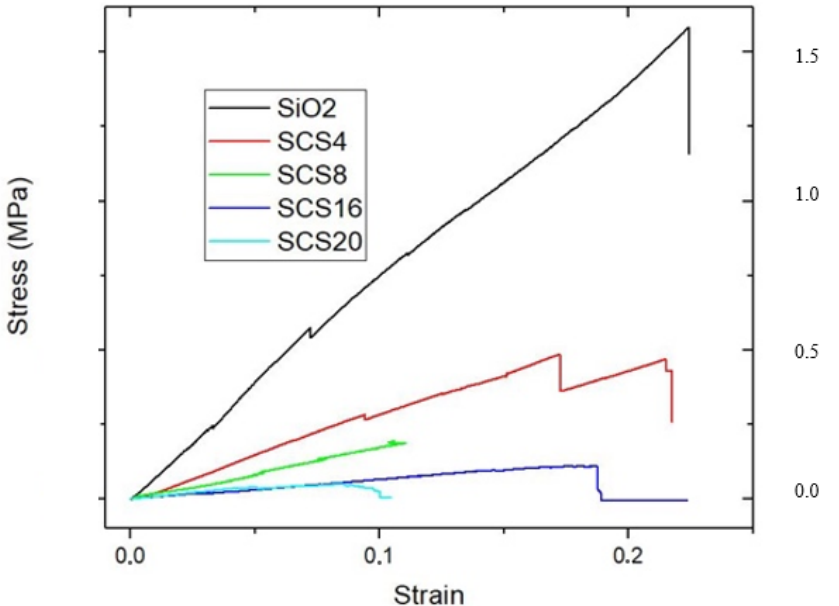
Figure 6. Stress / strain curves to failure of the outlined aerogels.